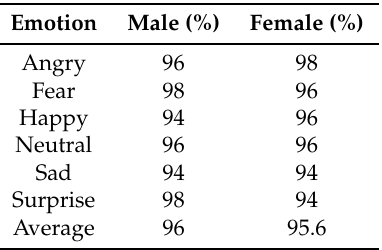
Table 4. Accuracy of male and female group using combining